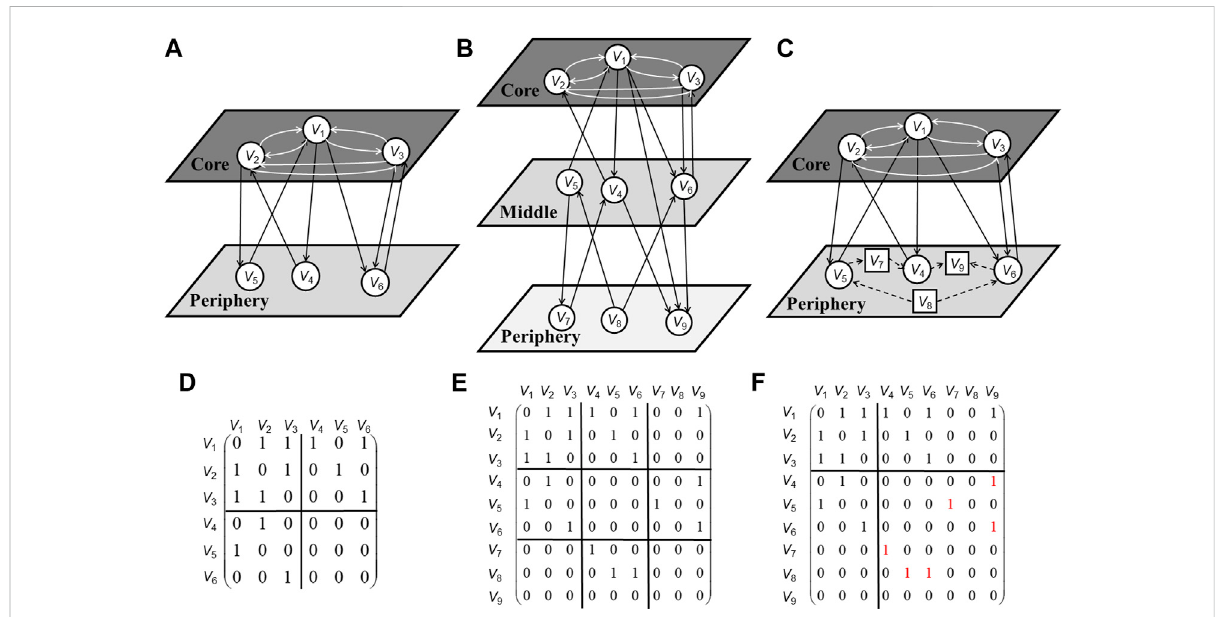
FIGURE 1 Ilustration of the core – periphery and core – middle – periphery models. (A) shows the schematic diagram of the idealized core-periphery structure. (D) showstheadjacencymatrixcorrespondingto (A) . (B) givestheschematicdiagramoftheidealizedcore – middle – peripherymodelwith three core nodes, three middle, and three periphery nodes. (E) shows the adjacency matrix corresponding to (B) . (C) shows a possible result of modelling the market structure in (B) by the core – periphery model without the middle layer. (F) shows the adjacency matrix corresponding to (C) with red “ 1 ” s indicating the errors in the periphery